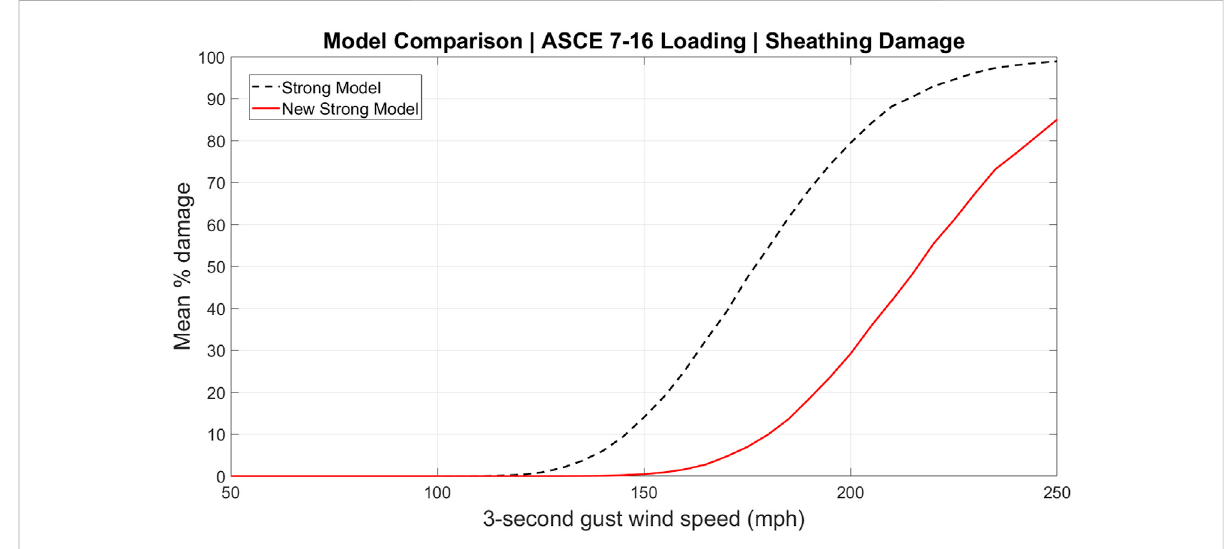
FIGURE 10 Vulnerability curves for roof sheathing damage of the strong and new strong models under ASCE 7 – 16